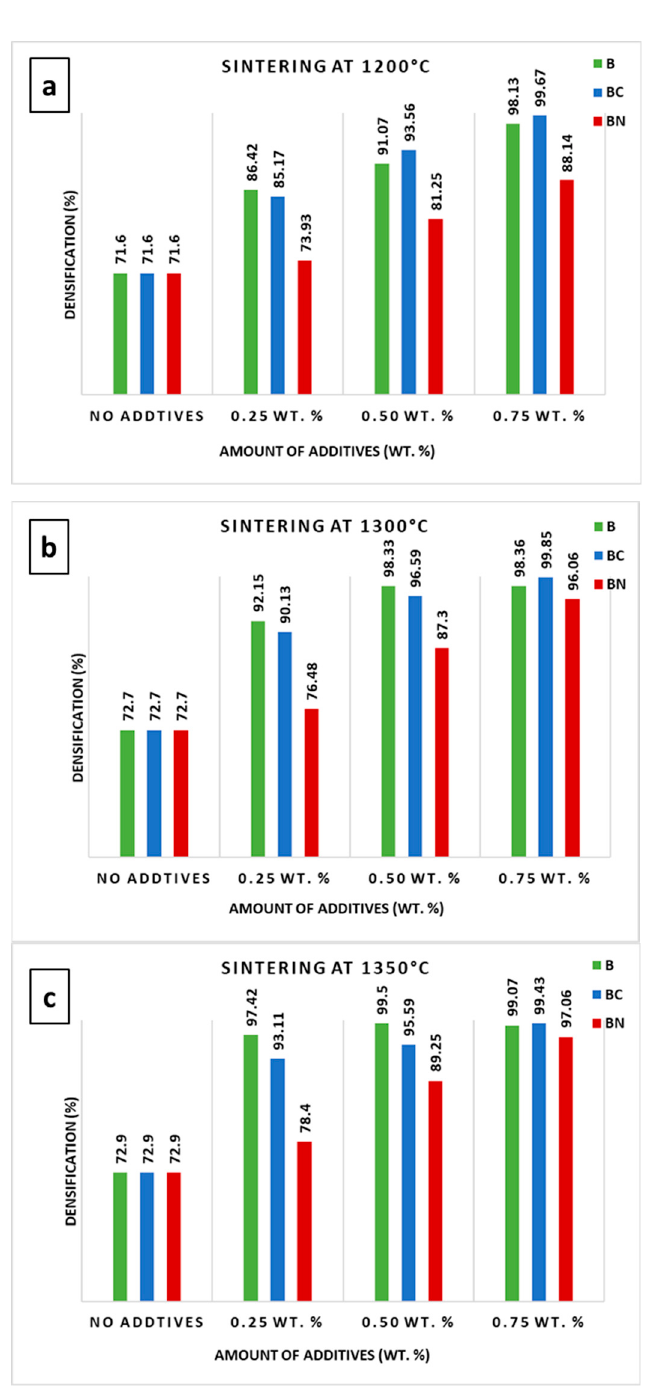
Figure 17. Densities of samples with different amounts of additives sintered at ( a ) 1200 °C, ( b ) 1300 °C, and ( c ) 1350 °C.